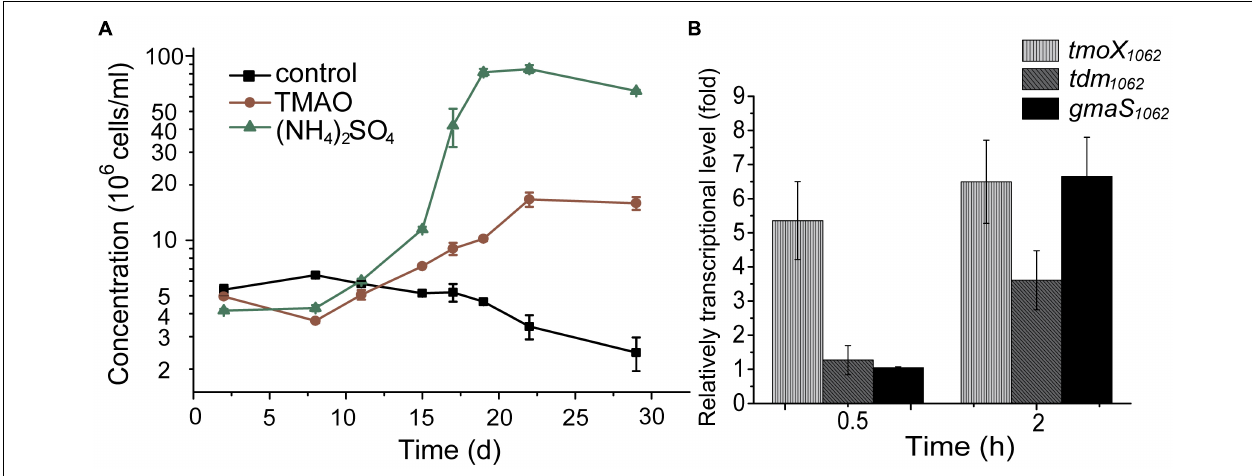
FIGURE 2 | TMAO utilization by strain HTCC1062. (A) The growth curves of HTCC1062 with 0.8 mM TMAO or 0.4 mM (NH 4 ) 2 SO 4 as the sole nitrogen source. DMSP was used as the sulfur source. Bacterial cells cultured without nitrogen source were used as the control. The concentration of bacteria was determined by flow cytometry. (B) RT-qPCR assay of the transcriptions of genes possibly involved in the TMAO transport and metabolism in HTCC1062. The bacterium cultured without TMAO in the same medium was used as the control. The recA gene was used as an internal reference gene. The error bar represents standard deviation of triplicate experiments.